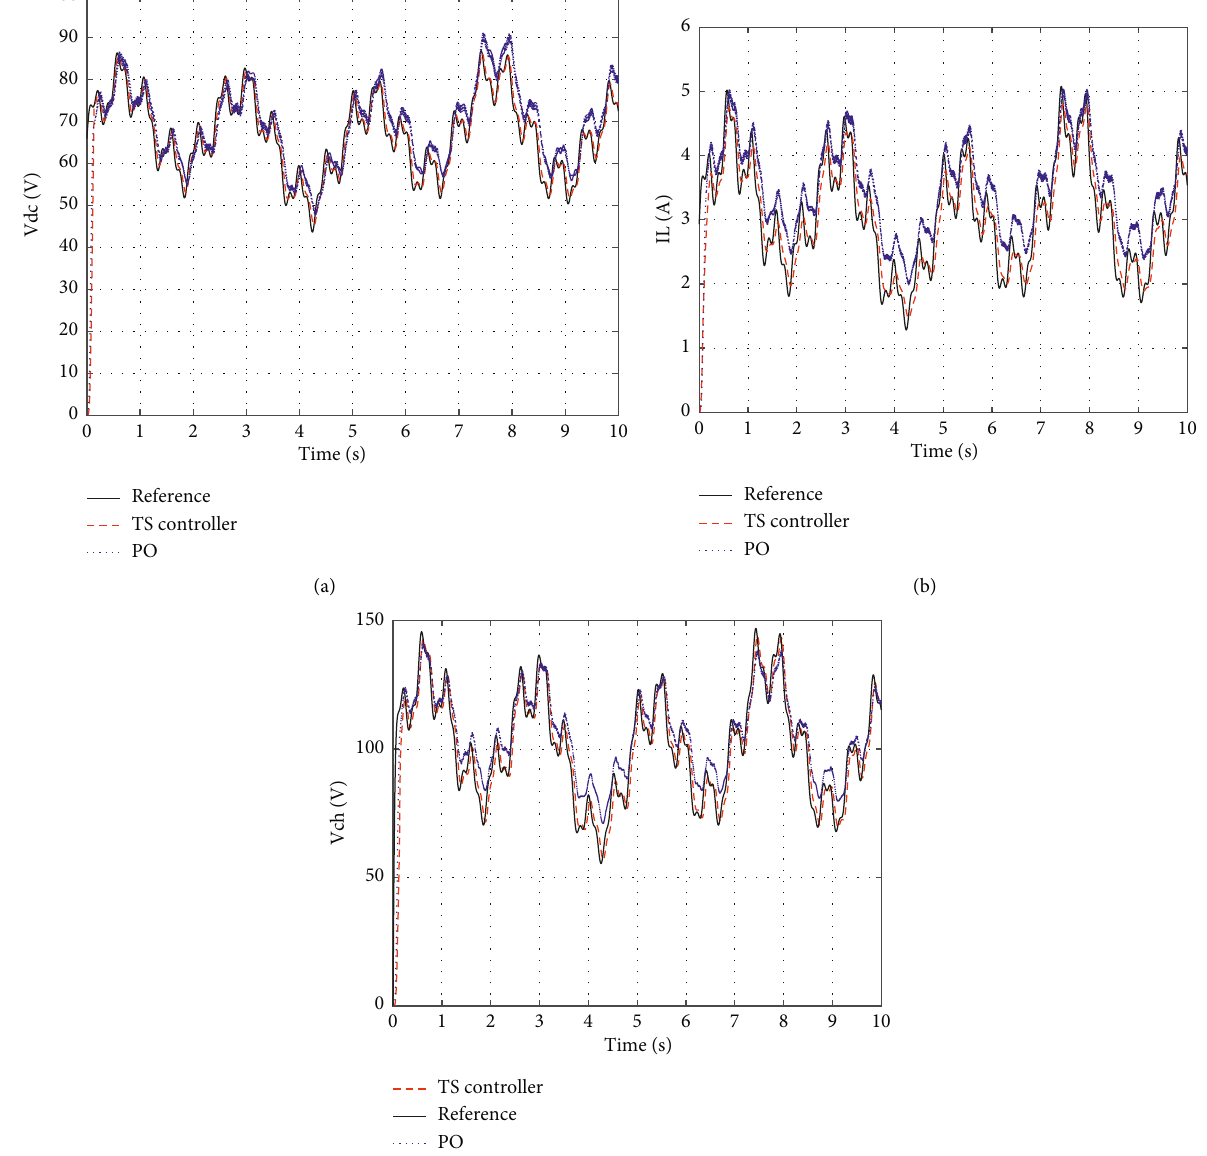
Figure 5: Time evolution of (a) rectified DC voltage, (b) inductance current, and (c) load